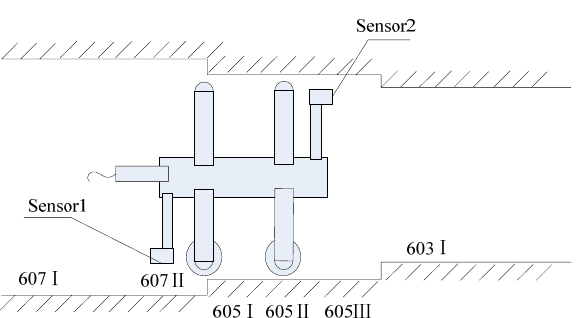
Figure 8. Position of the six profiles.